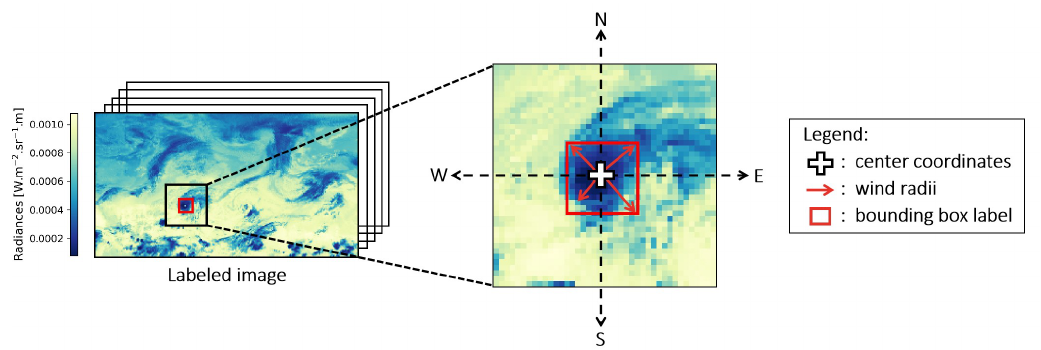
Figure 5. Image labeling